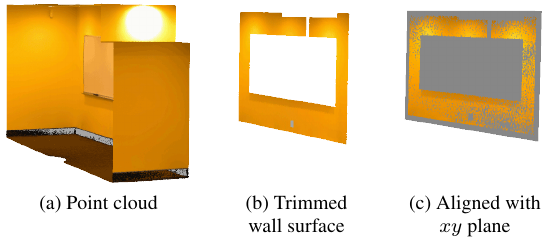
Figure 12. Aligning test wall with xy plane at z = 0